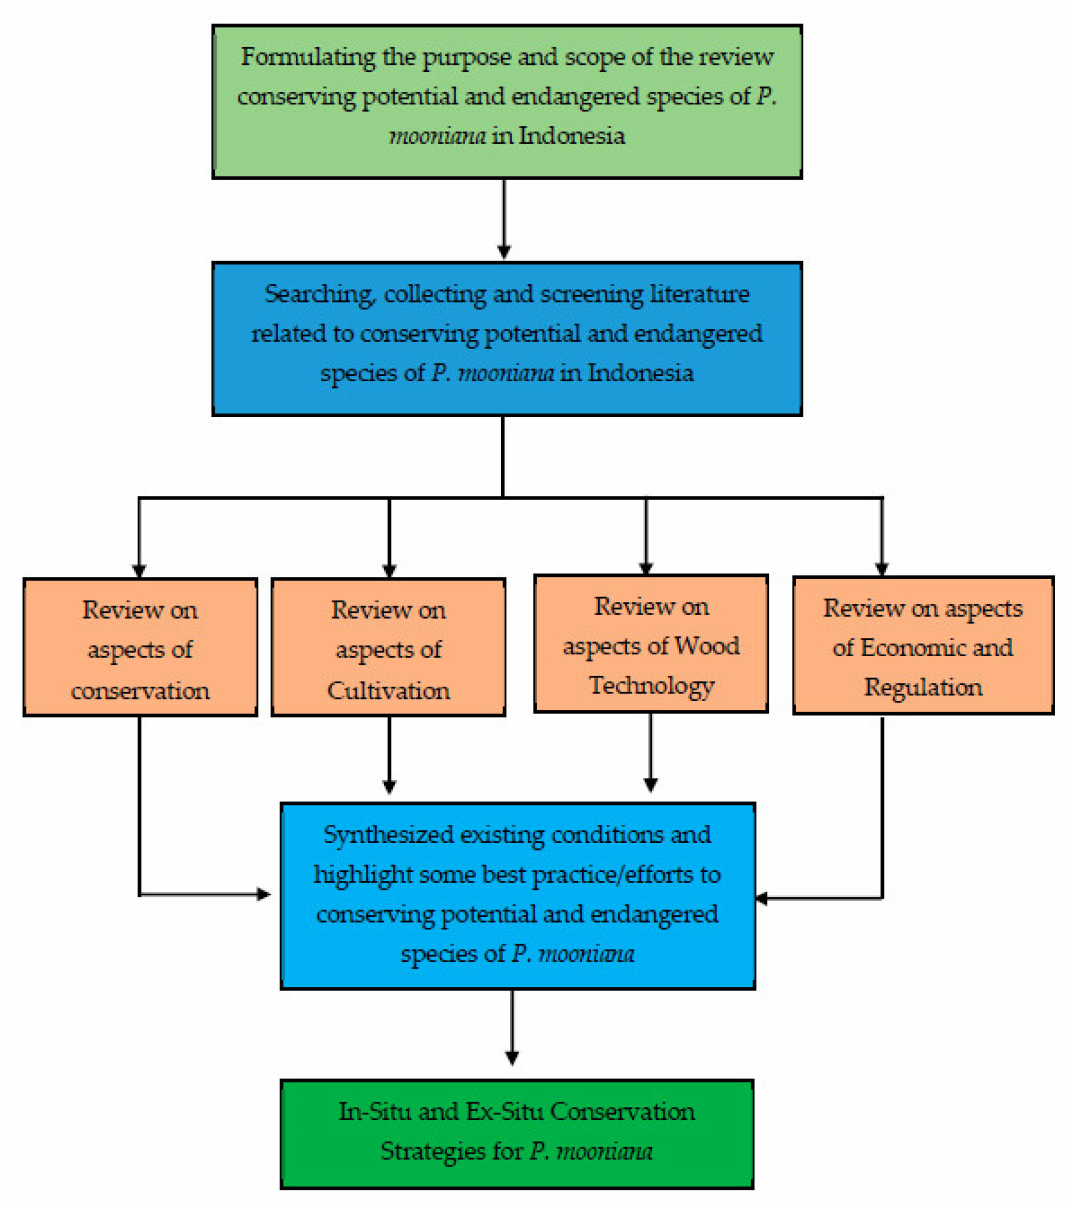
Figure 1. Stages in conducting the